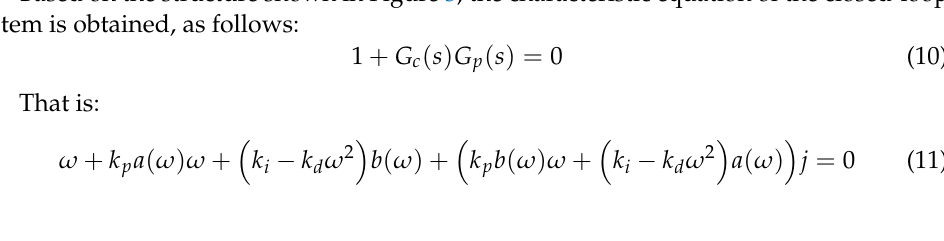
Figure 3. The closed-loop system consisted of the PID controller and the equivalent controlled ob- ject.